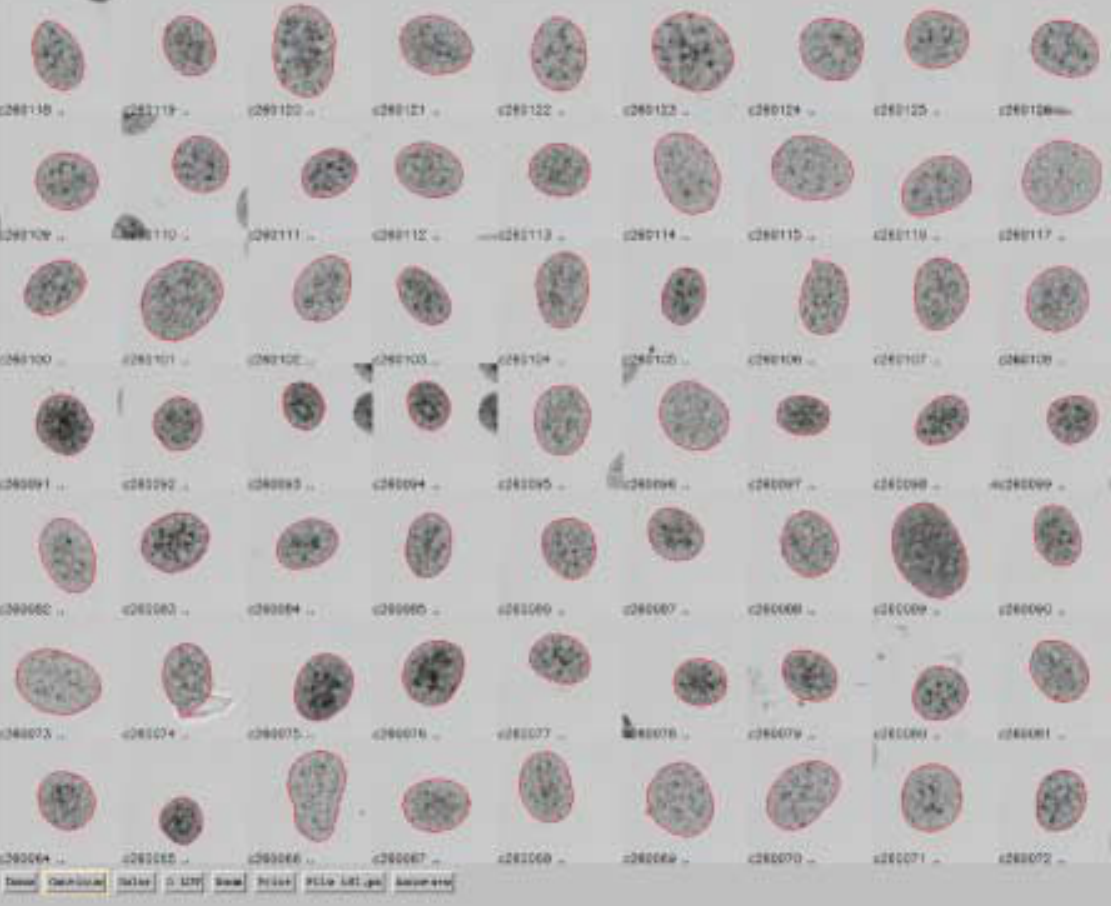
Fig. 3. Display of images from a specimen consisting of single cell images. This figure can be viewed on http://www.esacp.org/acp/2003/